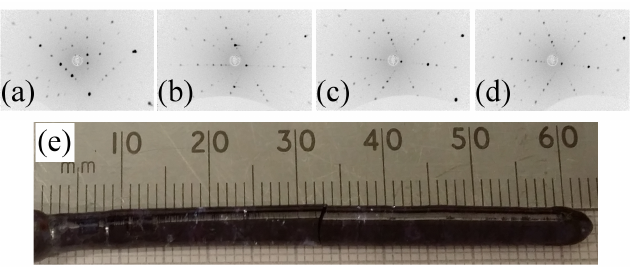
Figure 9. ( a – d ) Laue patterns of one of the facets of a Nd 2 Zr 2 O 7 crystal, taken along the crystal length at „ 15 mm intervals, between the beginning (left) and the end (right) of the boule. The corresponding Laue patterns taken on the facet at 180 degrees are mirror images of these patterns; ( e ) Crystal of Nd 2 Zr 2 O 7 grown in air at a rate of 12.5